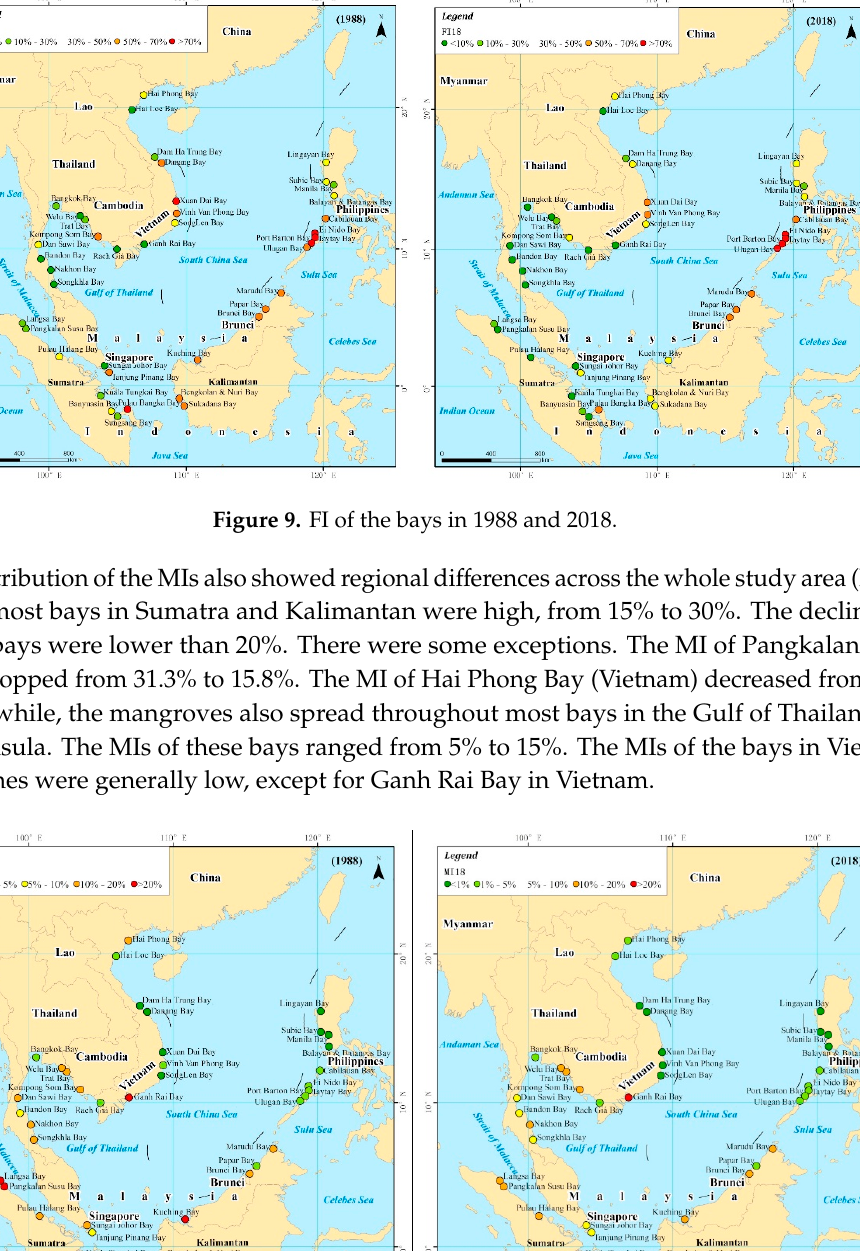
Figure 8. Type and percentage of agricultural land in 1988 and 2018.